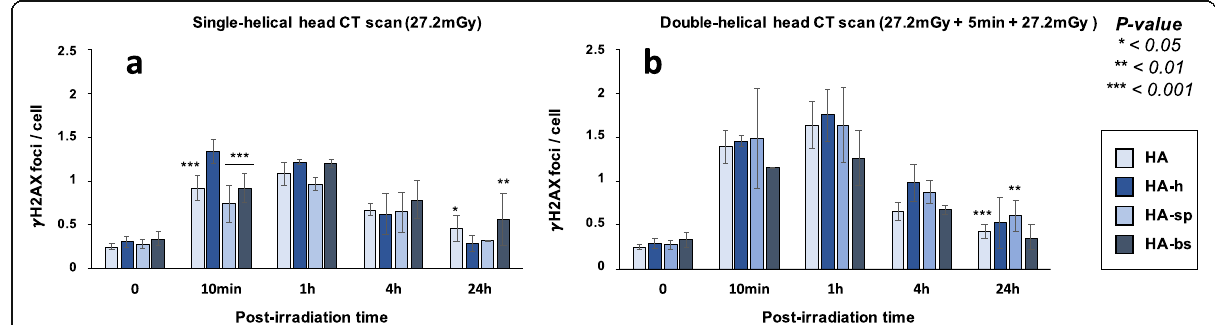
Fig. 6 γ H2AX foci in astrocytes after single and double-helical CT-scan exposure. a Kinetics of γ H2AX foci in astrocytes after a single helical head CT scan, or ( b ) a double-helical head CT scan at the indicated times after exposure (t0 = non-irradiated). Each data represents the mean ± SEM foci per cell of 3 independent experiments. The asterisks shown at 10 min post-irradiation times correspond to a statistically significant difference between HA-h and the three other cell lines. For time 24 h, asterisks correspond to a statistically significant difference from the non-irradiated conditions for the same cell line. CT Computed tomography, γ H2AX Phosphorylated forms of the H2AX histone variant molecular, SEM Standard error of the